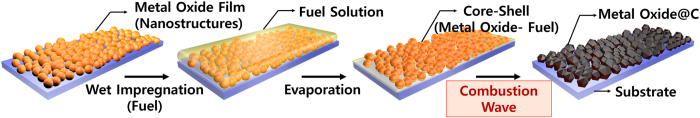
Detailed steps of facile one-pot transformation of nanostructured Fe3O4@C core-shell composites from Fe2O3 via combustion wave.